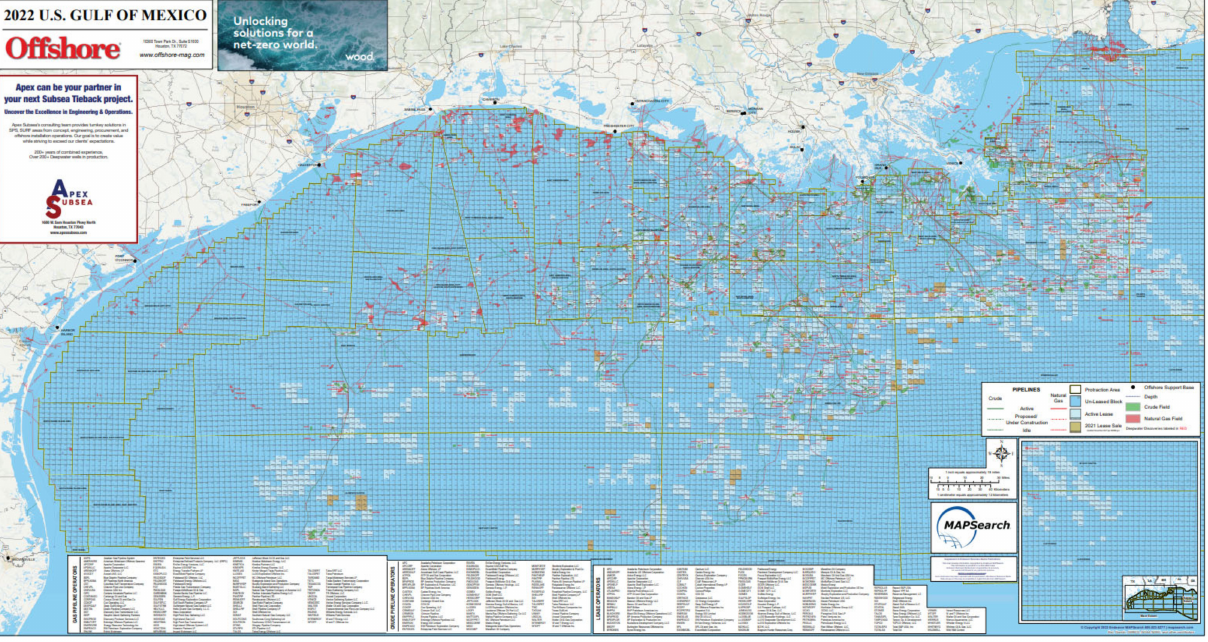
Figure A7. Map of Gulf of Mexico showing Deep water explorations as at 2020 (Courtesy: QuestOff- shore and Offshore